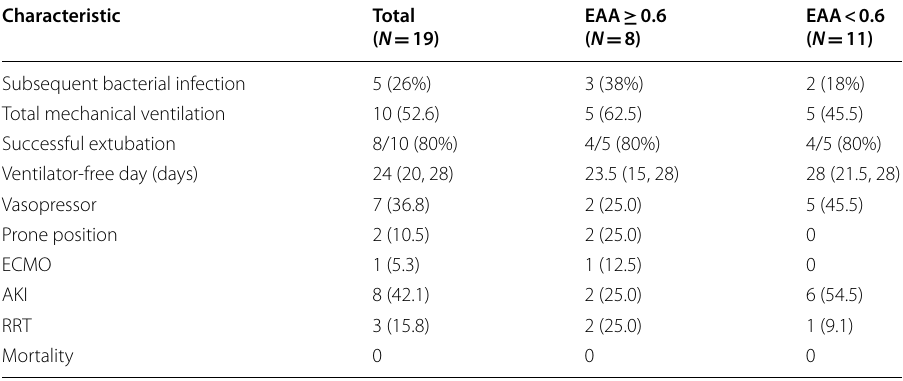
Table 2 Outcomes at 28 days after enrollment